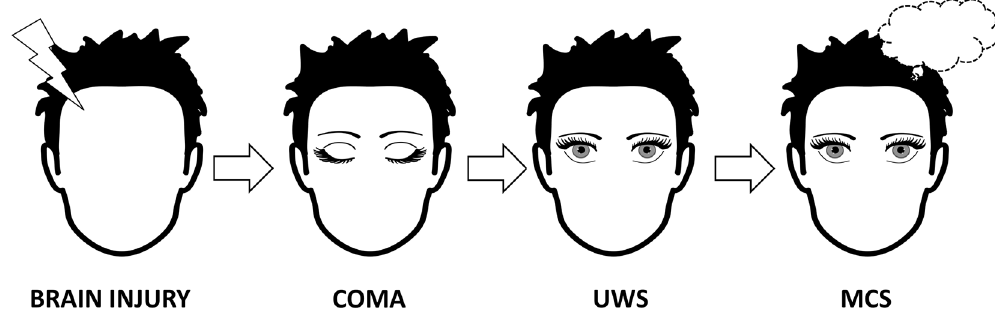
Figure 1. Recovery after severe brain injury. According to the clinical definition, transition from coma to Unresponsive Wakefulness Syndrome (UWS) is denoted by the eyes opening, which is interpreted as a sign of regained arousal. Reproducible evidence of recovered awareness is a hallmark of Minimally Conscious State (MCS), but is already assigned as soon as a patient can visually fixate (MCS − ). A step further up, patients are termed MCS + if they are sometimes able to communicate in some form with the